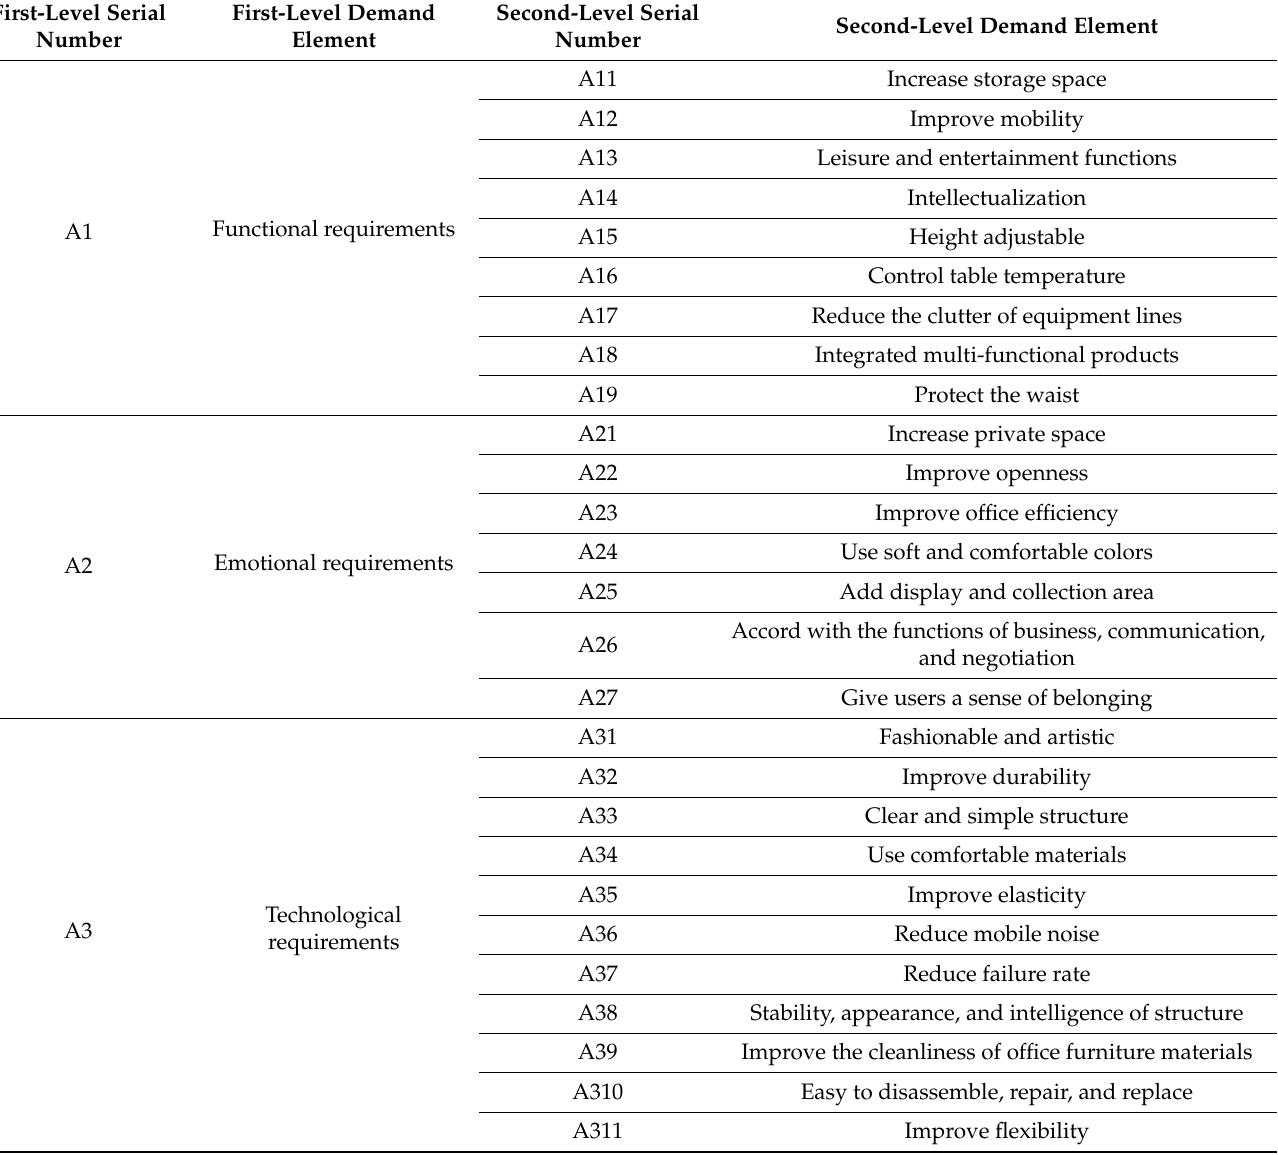
Table 2. Definitions of wood desk user demand